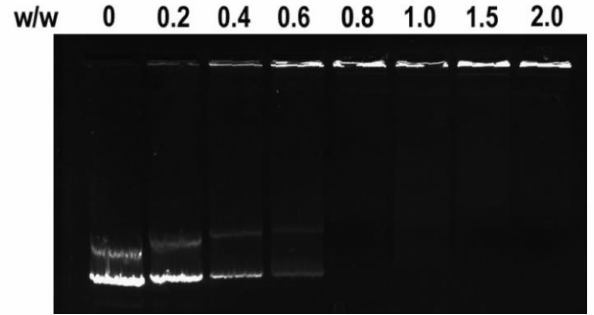
Figure 2. Agarose gel electrophoresis retardation assays of DOX-NPs/pDNA complexes at different w / w ratios.